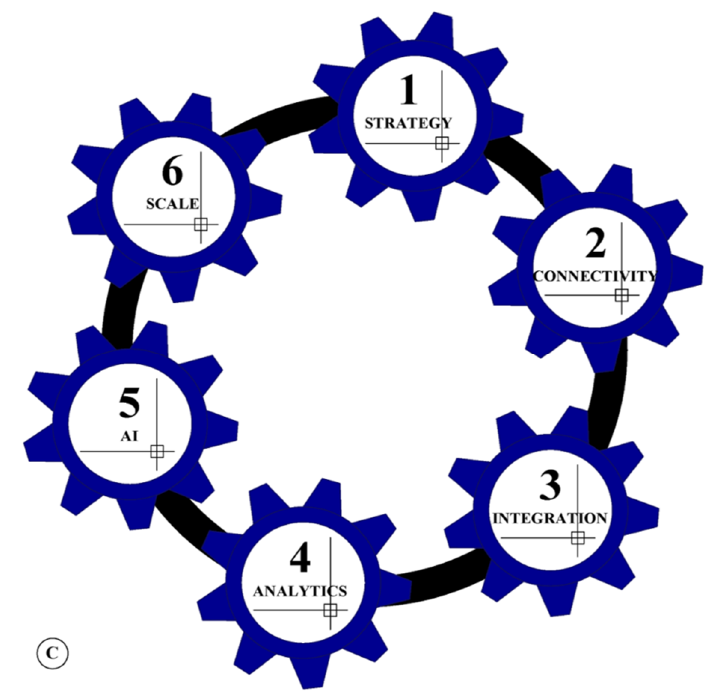
Figure 4. The six gear roadmap towards the smart factory.